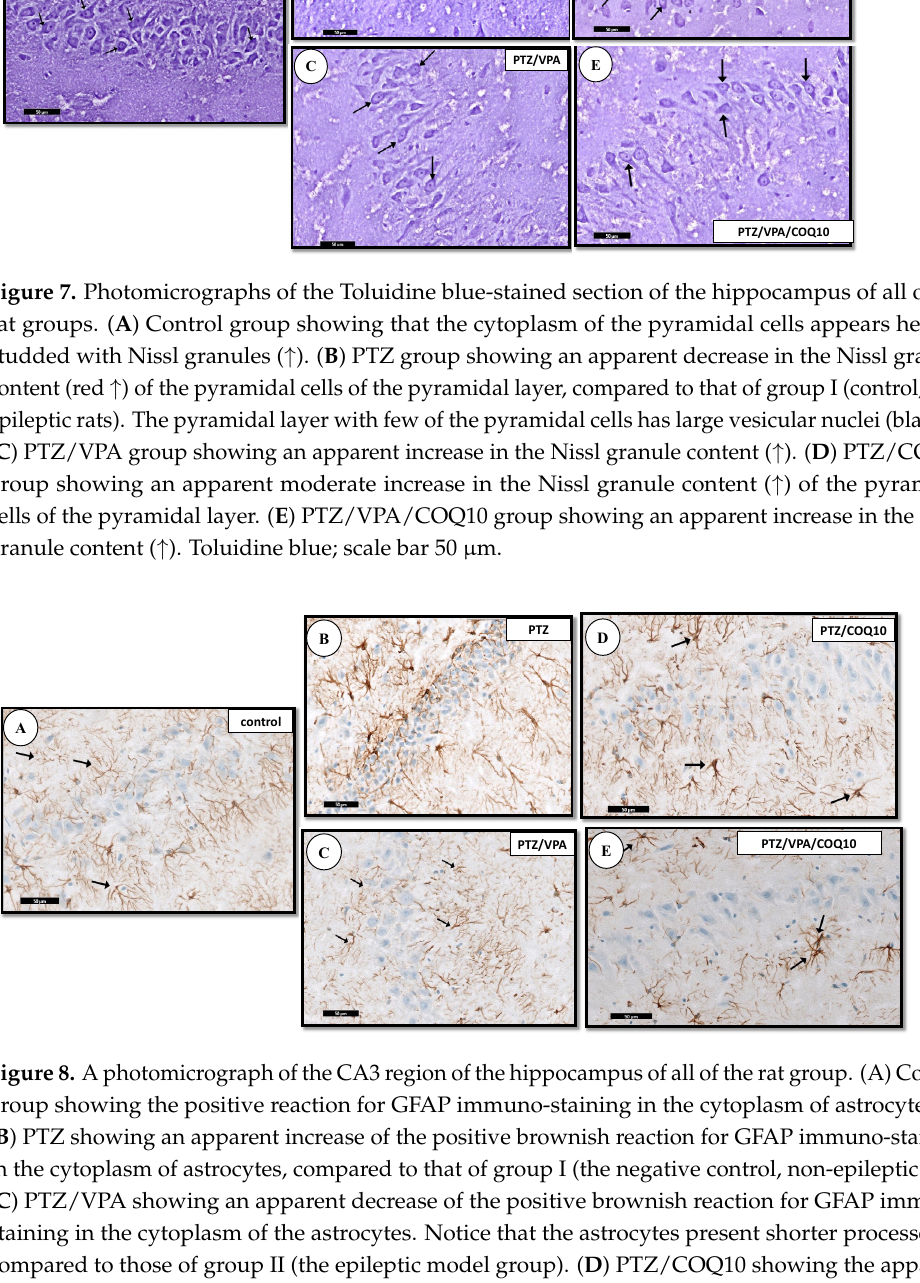
13 of 21 Figure 6. A photomicrograph of a parasagittal section of the hippocampus of all of the rat groups . ( A ) The negative control showing the normal architecture of the hippocampus. ( B ) The PTZ group showing the predominance of the degenerated, deeply stained, shrunken neurons with per neuronal spaces within the pyramidal layer ( ↑ ). Notice the pale, vacuolated areas in the molecular layer (M) suggesting the concurrent swelling/degeneration of the pyramidal cell axons (yellow ↑ ). ( C ) The PTZ/VPA group showing the presence of occasional, deeply darkly stained cells ( ↑ ). ( D ) The PTZ/COQ10 group showing most of the pyramidal cells, which have large rounded vesicular nuclei (red ↑ ). Few deeply stained cells are present with per neuronal spaces (black ↑ ). ( E ) The PTZ/VPA/COQ10 group showing the pyramidal layer which formed of pyramidal cells ( ↑ ) with vesicular nuclei and basophilic cytoplasm. The outer polymorphic layer, PM; the middle pyramidal layer, P; the inner molecular layer, M. Notice the presence of the lateral ventricle (lV). H&E/scale bar 50. Nissl ‐ stained sections: The PTZ group showed an apparent decrease in the Nissl